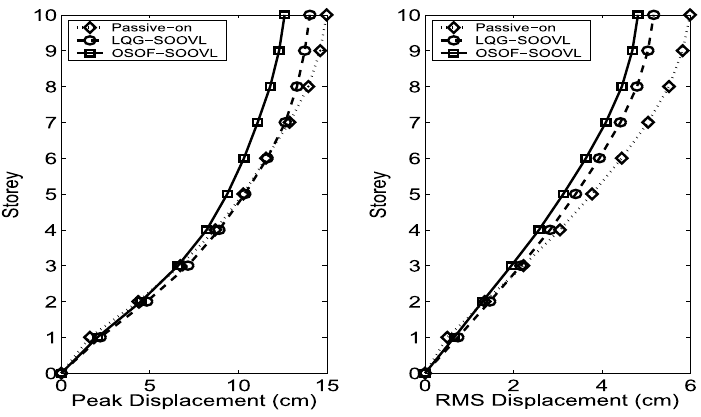
Fig. 5. Storeywise peak and RMS